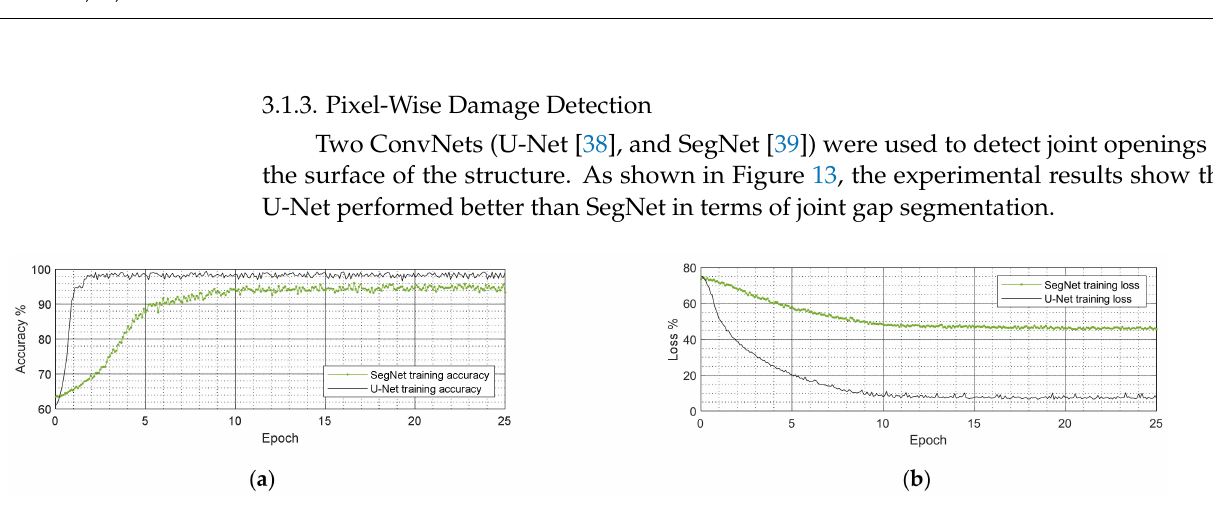
Figure 13. ( a ) Accuracy and ( b ) loss training curves for both studied CNNs.